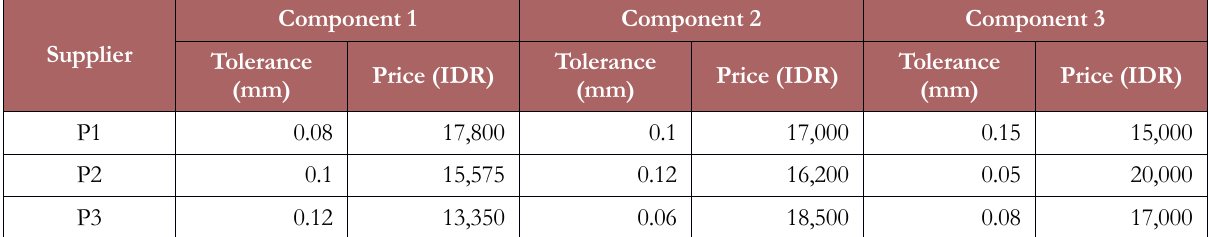
Table 2. Price and tolerance data for each component for each supplier